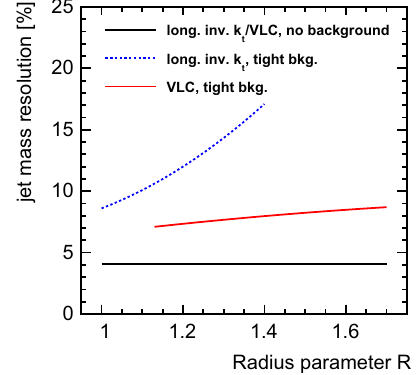
Fig. 15 The bias and resolution of the reconstructed jet mass versus radius parameter R of two jet algorithms. The jets are reconstructed in fully hadronic top-quark decays in t ¯ t events at a center-of-mass energy of3TeV.Thejetsreconstructedfromparticle-flowobjectsarecompared